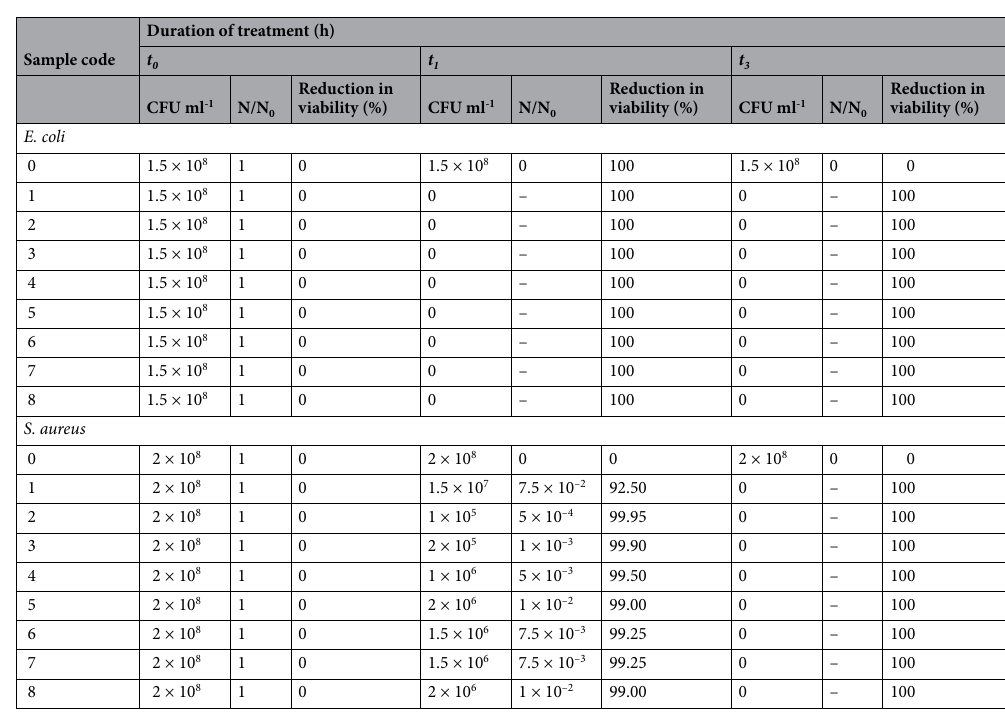
Table 2. Antibacterial activity test using E.coli and S. aureus . The viable bacteria were monitored by counting the number of colony-forming units (CFU). N/No: survival fraction, Sample 0 (Uncoated fabric), Samples 1–4 and 5–8 (NS-coated fabrics at 2, 10, 20, and 50 mM silver nitrate concentrations, and 25 and 50 min sonication time,